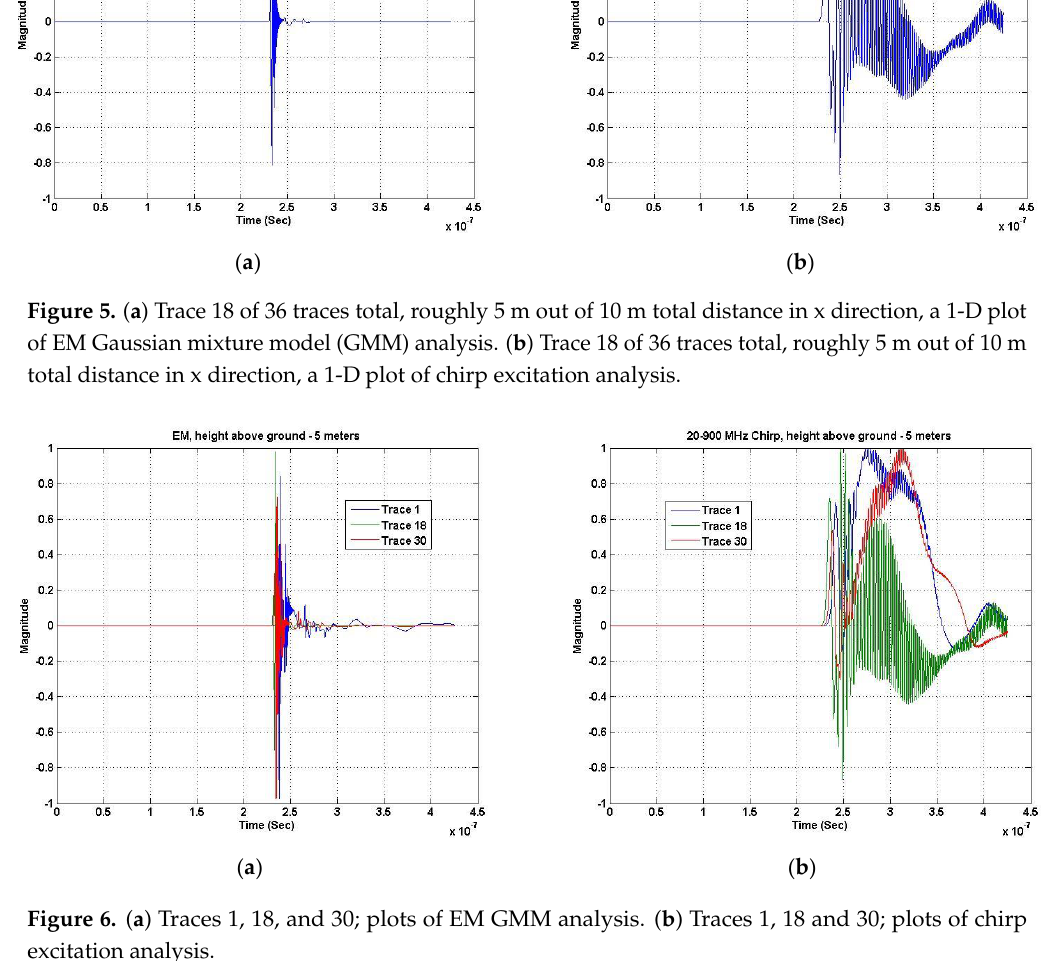
Figure 6. ( a ) Traces 1, 18, and 30; plots of EM GMM analysis. ( b ) Traces 1, 18 and 30; plots of chirp excitation analysis.